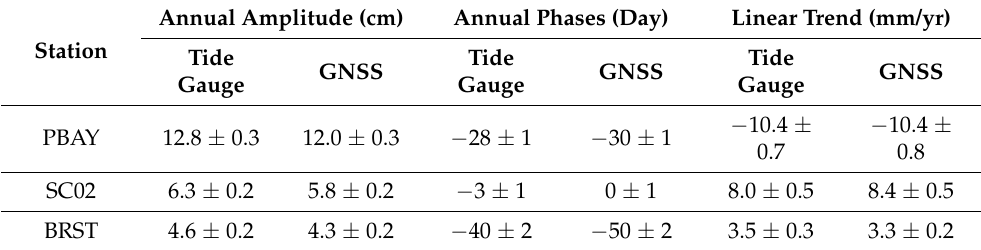
Table 1. Comparison of estimations of annual amplitudes, annual phases and linear trends from GNSS-IR and tide gauges. Uncertainties indicate a 1-sigma standard